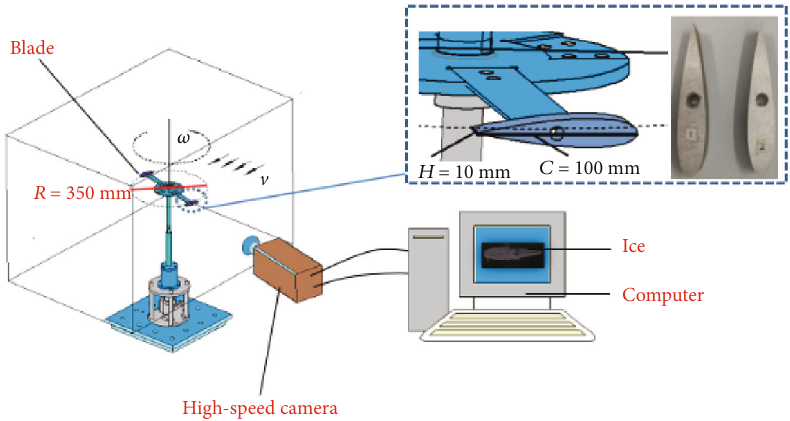
Figure 13: Rotor test stand and icing shape collection system.